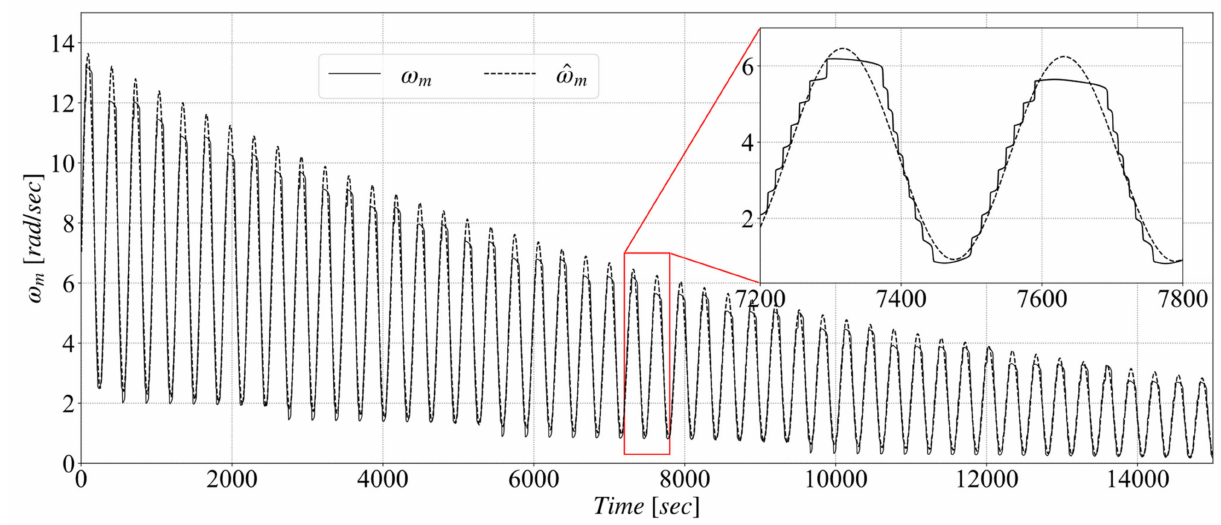
Figure 6. Comparison between fitted model and original data for state